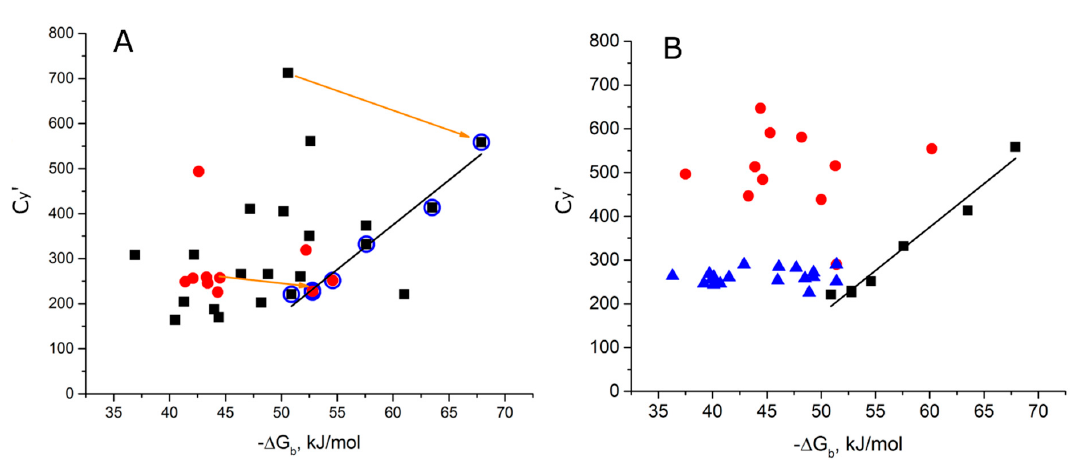
Figure 5. Capacity of energy transfer (C y ′ ) plotted versus changes in Gibbs free energy. ( A ) Aptamer–protein complexes: G-quadruplex aptamers to thrombin are shown as red dots; all other aptamers are shown as black dots; and 7 dots chosen for linearization are shown with blue circles. The linear dependence is described with the equation y = 19.9x − 818 with R 2 = 0.97. Examples of improvement of aptamer affinity are shown with orange arrows that are drawn from non-optimal to optimal complexes. ( B ) DNA helix–protein complexes: HTH-type proteins are shown as red dots; complexes of fis protein with different DNA helices are shown as blue dots; and linearized efficient aptamer–protein complexes are shown in black dots.